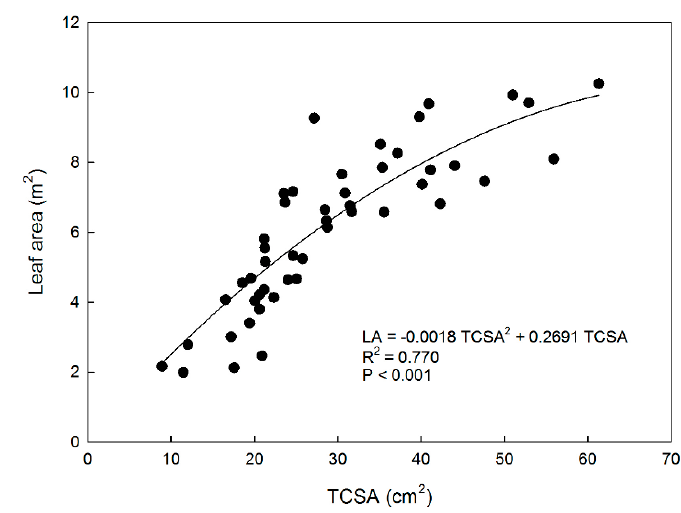
Figure 1. Relationship between trunk cross-section area (TCSA) and total leaf area (LA) in eight-year-old ‘Gala’ and ‘Fuji’ apple trees grafted on M.9 rootstock, trained to a central leader, spaced at 4 × 1.5 m, and grown near Caltavuturo, Sicily.